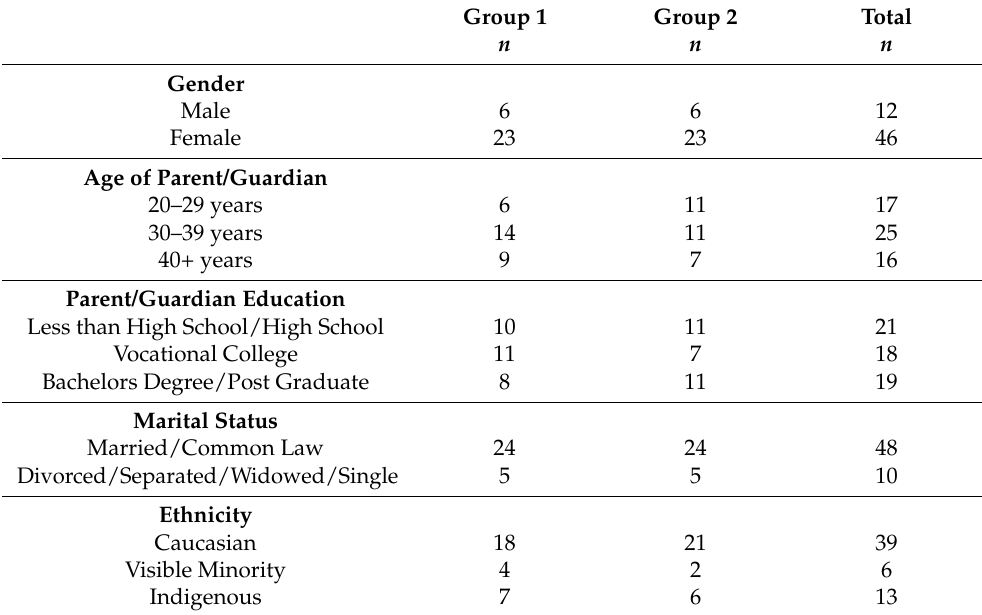
Table 2. Participant Demographic Characteristics.